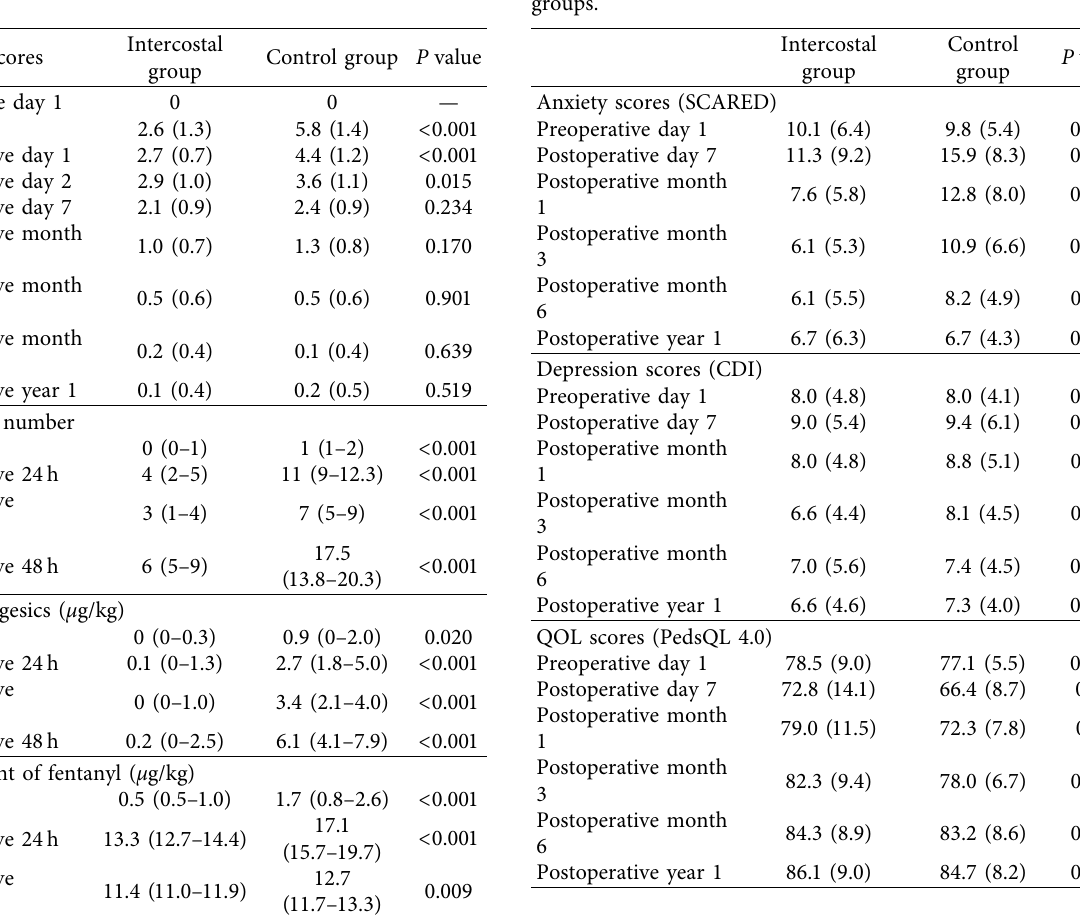
Table 4: Comparison of psychological outcomes between the two groups.